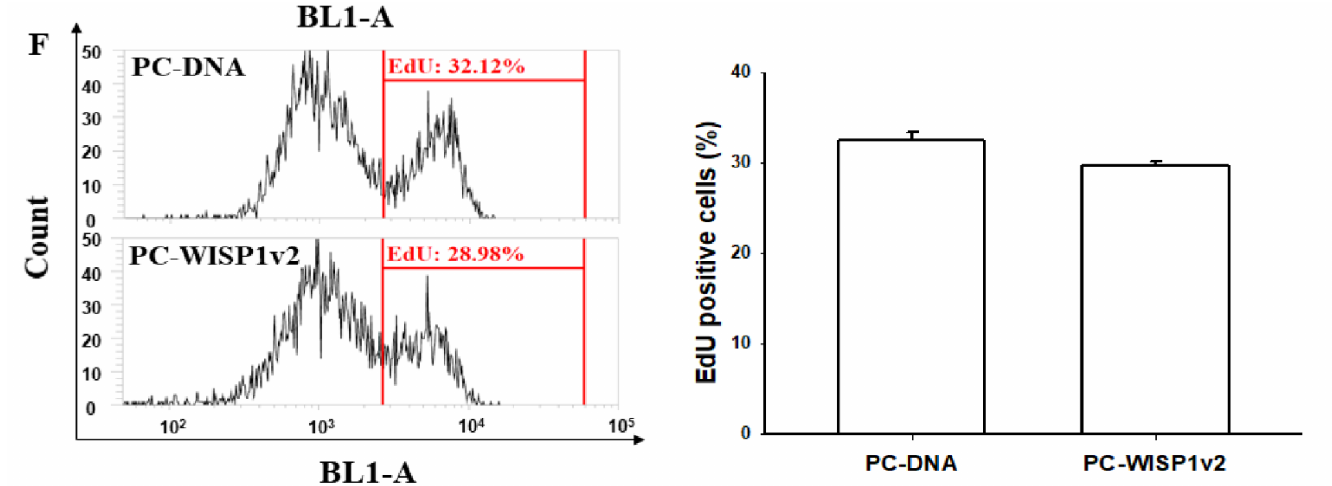
Figure 4. Modulating effect of WISP1v1 and WISP1v2 on the cell proliferation in prostate carci- noma PC-3 cells. Expressions of WISP1v1 and WISP1v2 after the ectopic-overexpressed WISP1v1 and WISP1v2 in the PC-3 cells were assessed by RT-PCR ( A ), ELISA ( B ), and RT-qPCR ( C ) assays. ( D ) The expressions of WISP1v1, WISP1v2, NDRG1, and β -actin were determined by immunoblot assays (M: 100 bp Marker; 1: PC-DNA; 2: PC-WISP1v1; 3: PC-WISP1v2). The abilities of the prolifera- tion of PC-DNA, PC-WISP1v1 ( E ), and PC-WISP1v2 ( F ) cells were measured by EdU flow cytometry assays. Data are presented as the mean percentage of the EdU positive cells ( ± SE; n = 4). ** p <